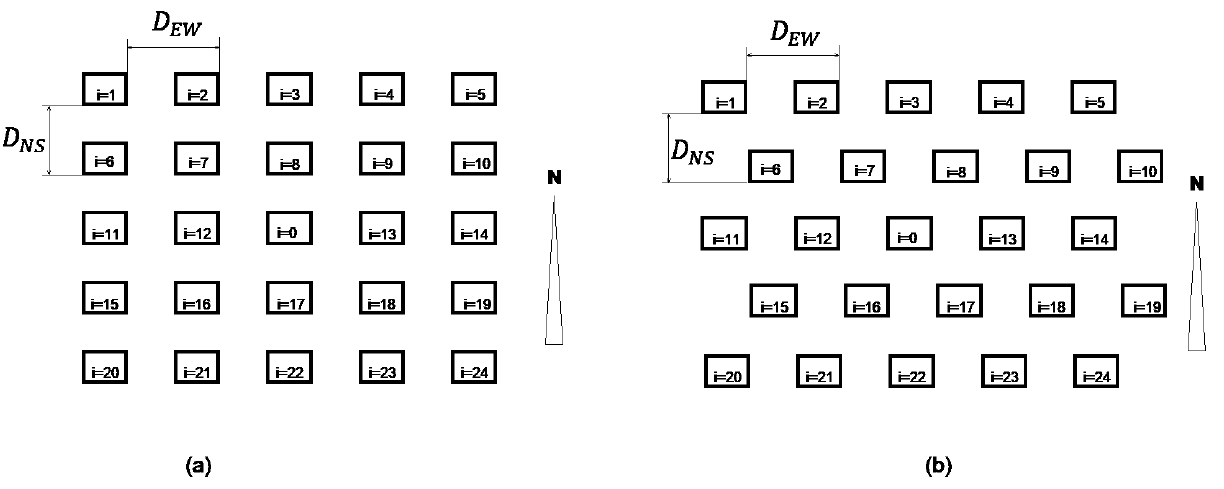
Table 1. Data considered for the estimation of the annual solar irradiance in “El Molino” PV Plant (Cordoba, Spain): horizontal daily radiation, H [48] and representative day proposed by [47] each month of the year.